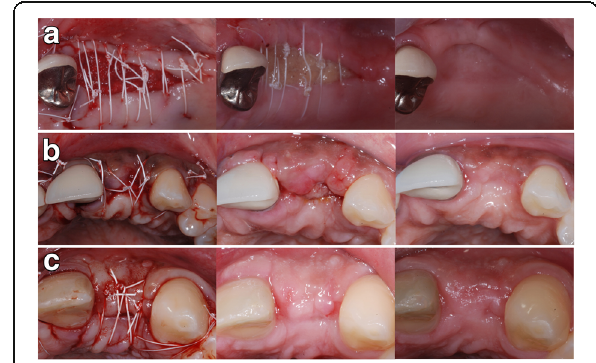
Fig. 1 Clinical photographs of the both treatment groups after the initial surgery, 1 week post-op and at the re-entry. a ) In the test group, no primary wound closure was achieved ( left ) and the barrier was left exposed for secondary intention healing. After 1 week, the matrix remained exposed ( middle ) showing no signs of infection. For months later, the exposed area was covered by a keratinized tissue ( right ). b ) In the test group, primary wound closure was achieved at surgery ( left ). However, the barrier became exposed after 1 week of healing ( middle ). For months later, exposed area was covered with a keratinized tissue ( right ). c ) In the control group, primary wound closure was achieved ( left ). After 1 week ( middle ), primary healing happened without any signs of membrane exposure. For months later, the site healed uneventfully ( right